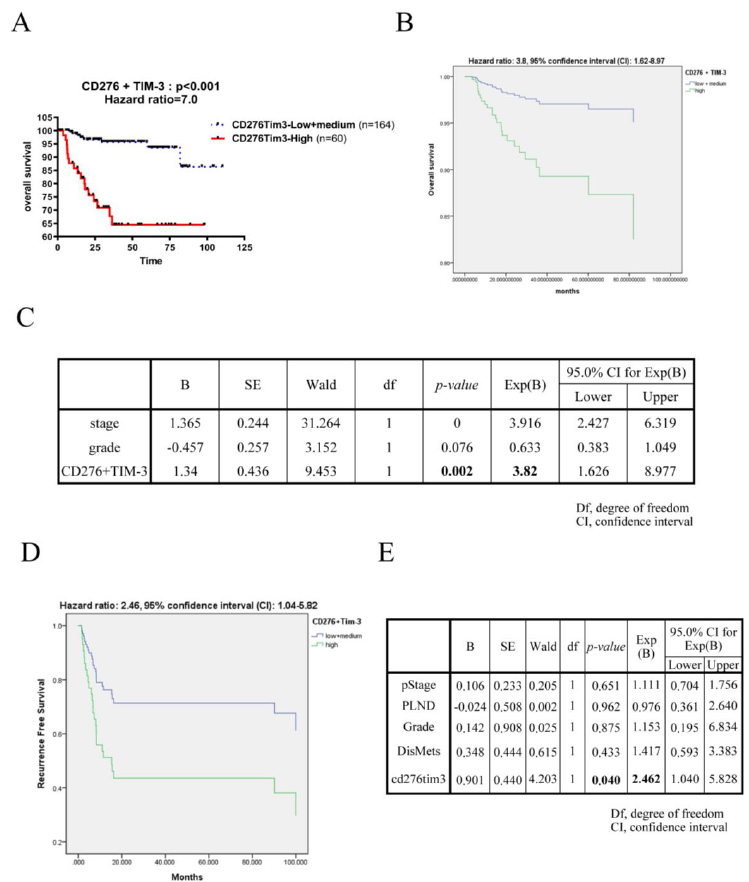
Figure 2. The combination of CD276 and TIM-3 was an independently poor prognostic biomarker of UC. ( A ) Univariate overall survival of 224 UC patients from GSE32894 was grouped by double-negative low, single-positive medium and double-positive high CD276 and TIM3 expression using the median value as the cut-off. The CD276TIM3 double-positive group consisted of 60 patients (red line), the CD276 and TIM3 single or double-negative group consisted of 164 patients (blue line). Kaplan-Meier survival analysis was performed. ( B ) Multivariate Cox regression survival plot of 224 UC pa- tients from GSE32894 was grouped as (A) described. ( C ) Results of the multivariate analysis from ( B ). ( D ) Multivariate Cox regression recurrent-free survival plot of 93 UC patients from GSE31684 was grouped by lower + medium ( n = 63) and higher ( n = 30) CD276TIM3 as ( A ) described. ( E ) Results of the multivariate analysis from ( D ). The p values were calculated by the log-rank test.